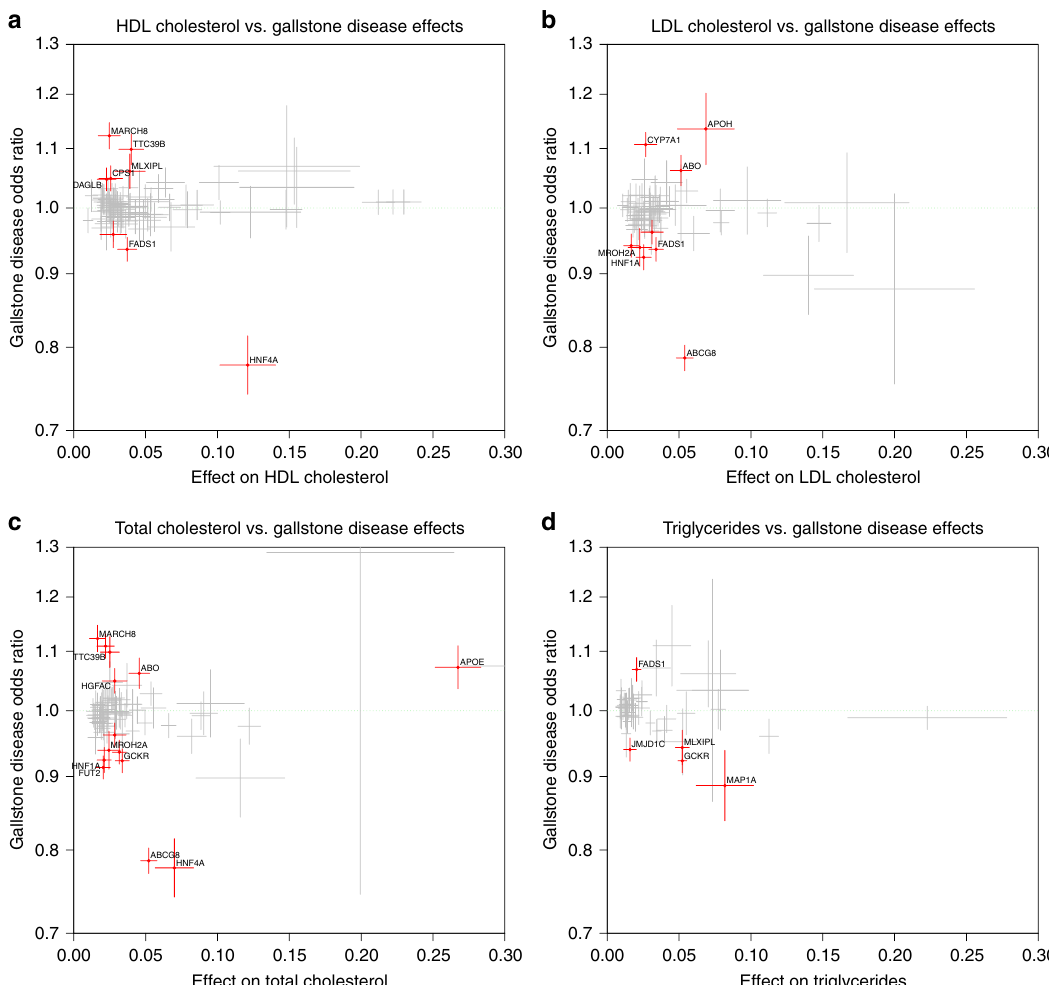
Fig. 4 203 variants reported to be associated with either HDL cholesterol, LDL cholesterol, total cholesterol or triglyceride levels: Effect of the allele associated with an increased level of serum lipids vs. odds ratio (OR) for gallstone disease, for a ) HDL cholesterol, b ) LDL cholesterol, c ) total cholesterol, and d ) triglycerides. Crosses indicate 95% con fi dence intervals. Variants with a signi fi cant OR for gallstone disease ( P < 0.05/203 = 2.6 × 10 ‒ 4 ) are shown in